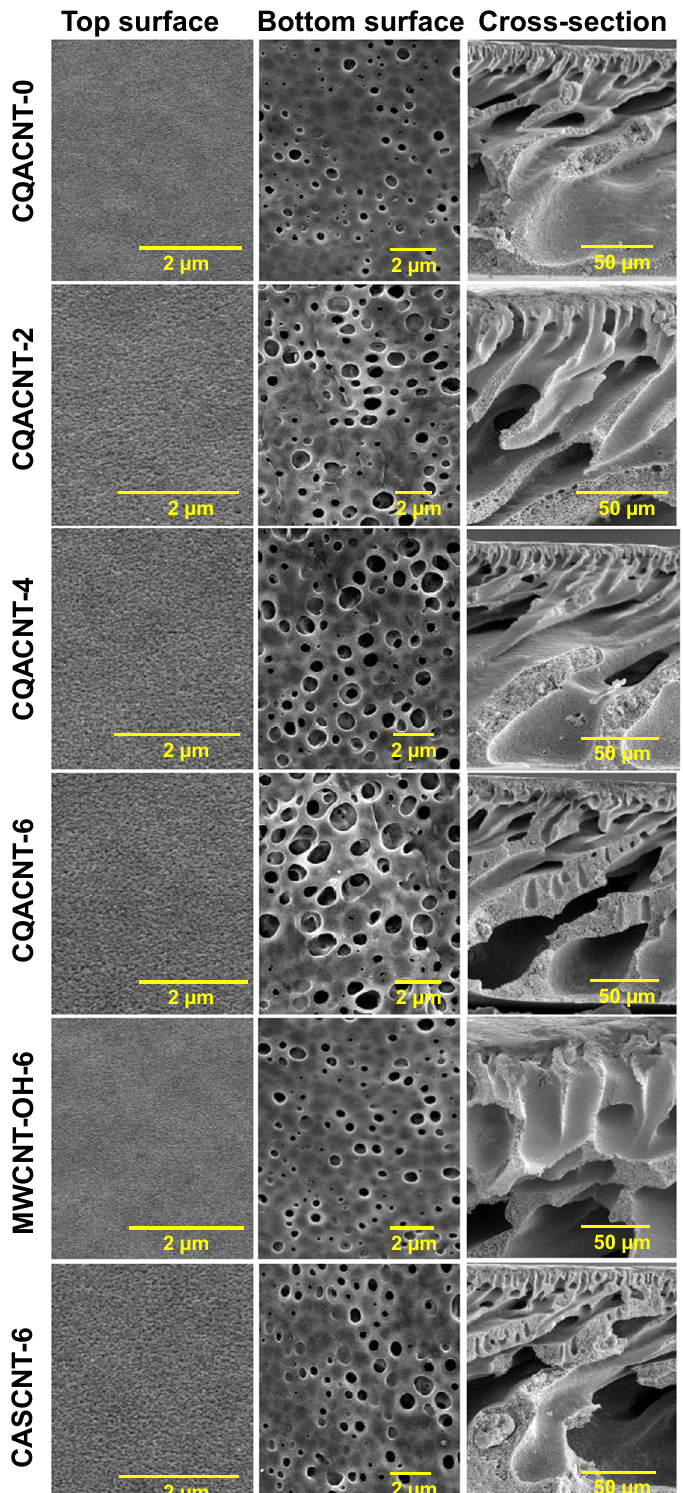
Fig. 4 Structural morphology of fabricated membranes. SEM micrographs of CQACNT (0-6), MWCNT-OH-6, and CASCNT-6 membranes: top surface, bottom surface and cross